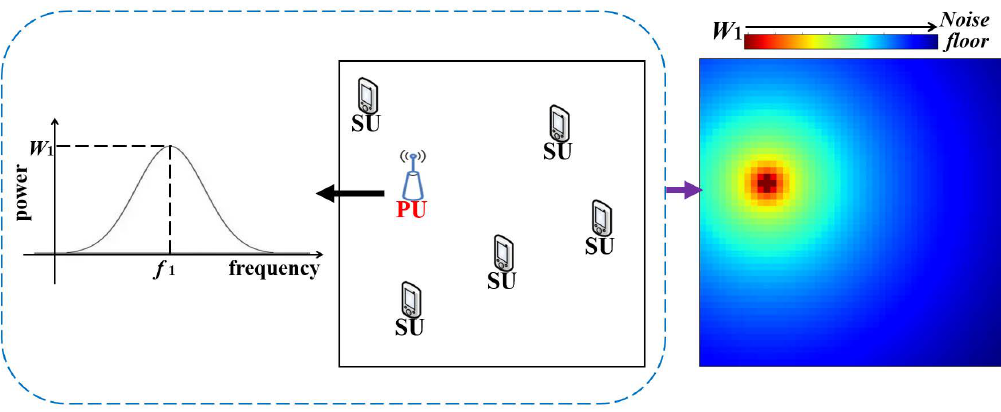
Figure 1. From left to right: The power spectrum of the PU; the distribution of the receiving SUs and the transmitting PU; the radio environment map of the target area in frequency f 1